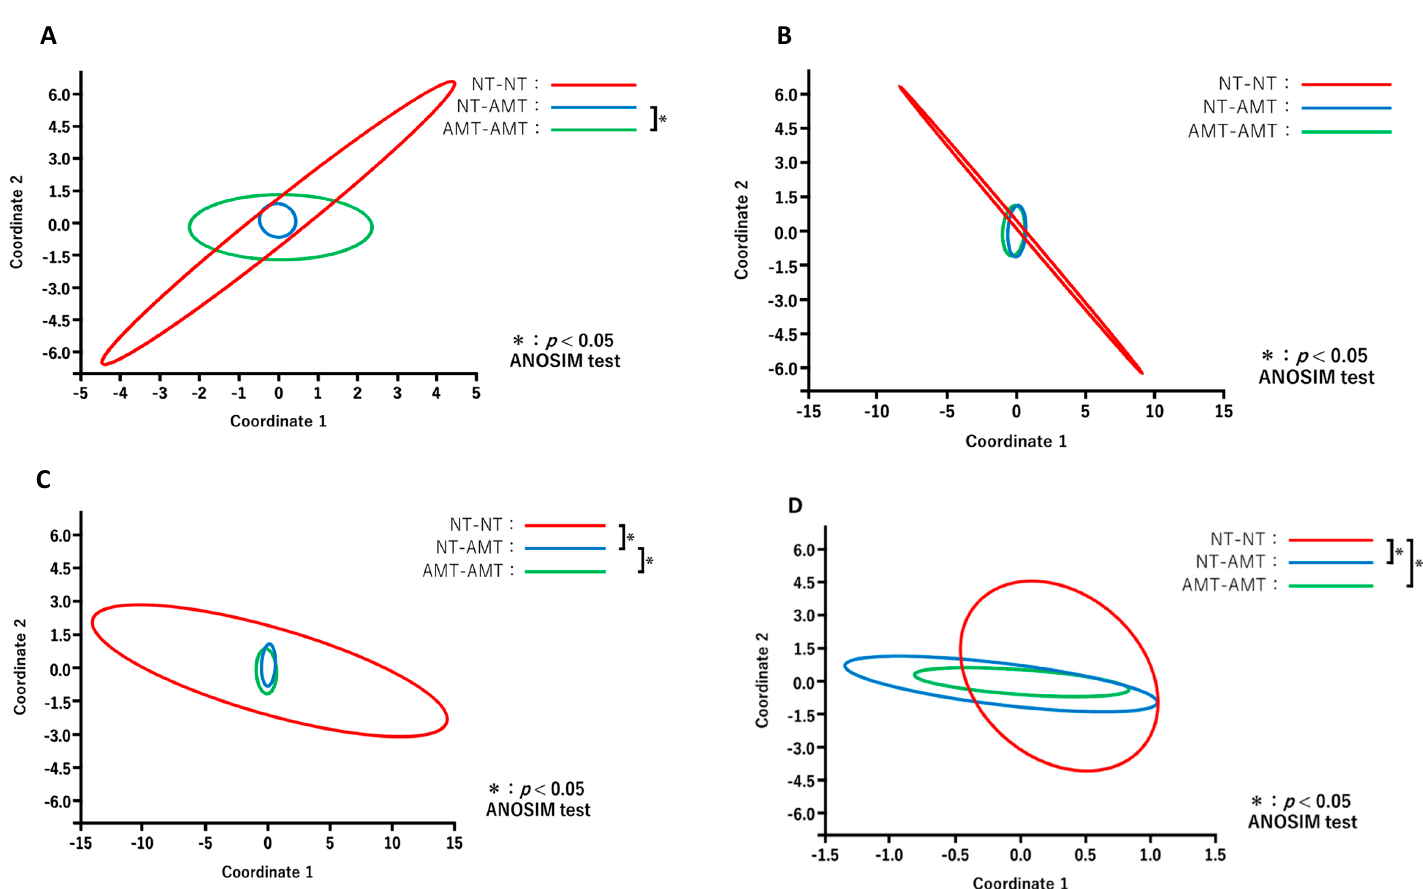
Figure 5. Principal coordinate analysis and ANOSIM test based on the Bray–Curtis distance comparing the microbiome data on day 0 ( A ), day 1 ( B ), day 3 ( C ) and day 7 ( D ) after treatment in each treatment group (NT-NT group, NT-AMT group and AMT-AMT group). ( A ) Comparison of the diversity between the treatment groups on day 0 after treatment. There was a significant difference between the NT-AMT and AMT-AMT groups. ( B ) Comparison of the diversity between the treatment groups on day 1 after treatment. There were no significant differences between the groups. ( C ) Comparison of the diversity between the treatment groups on day 3 after treatment. There were significant differences between the NT-NT and NT-AMT groups, and the NT-AMT and AMT-AMT groups. ( D ) Comparison of the diversity between the treatment groups on day 7 after treatment. There were significant differences between the NT-NT and NT-AMT groups, and the NT-NT and AMT-AMT groups.